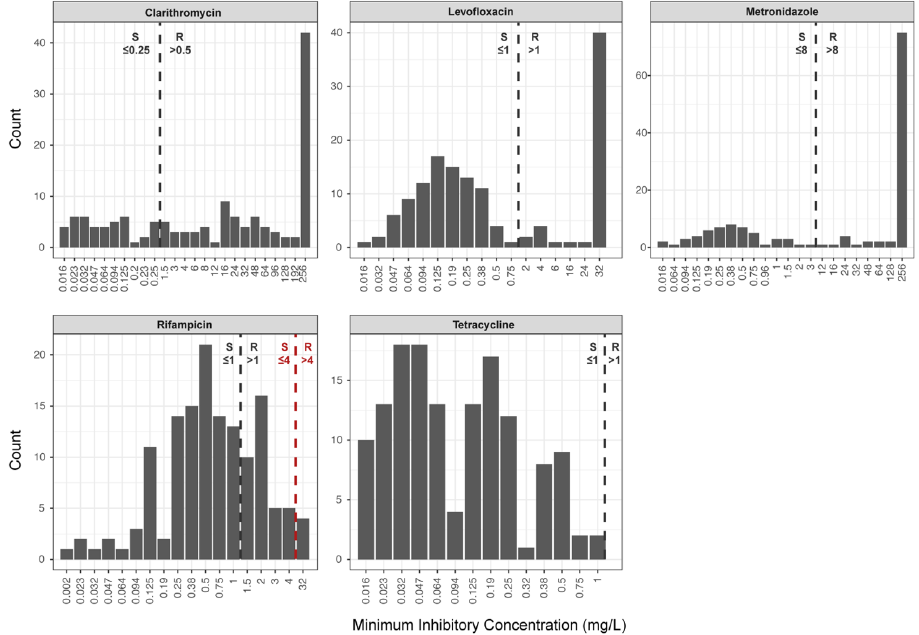
Figure 1. Antimicrobial drug susceptibility determined by E-Test ® in 140 clinical H. pylori isolates selected from the bacterial strain collection of the Institute of Medical Microbiology, University of Zurich, Switzerland. Clinical breakpoints issued by EUCAST [28] are displayed for all five drugs (black dashed line). For rifampicin, the clinical breakpoint of 4 mg/L [22,29] is displayed as a red dashed line; R denotes resistant and S denotes